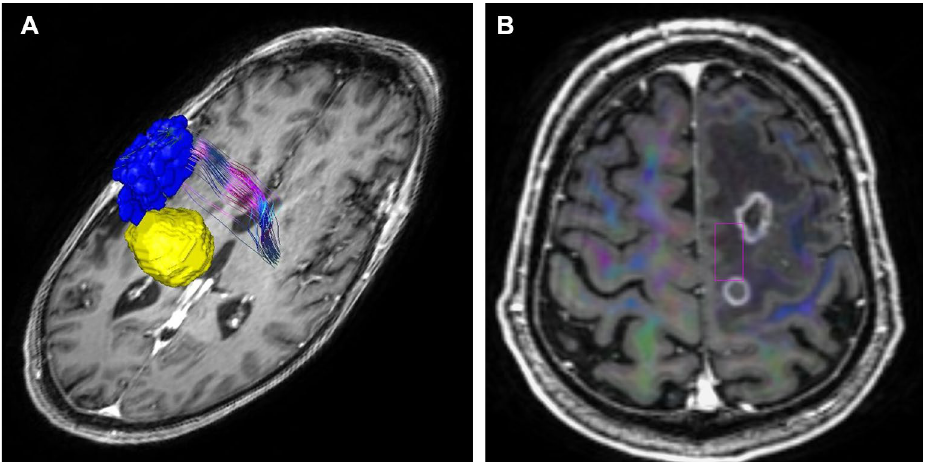
Figure 2. ( A ) nTMS based ROI (blue) creation and nTMS based reconstruction of the CST. The tumor is displayed in yellow. ( B ) Anatomical ROI seeding (pink).